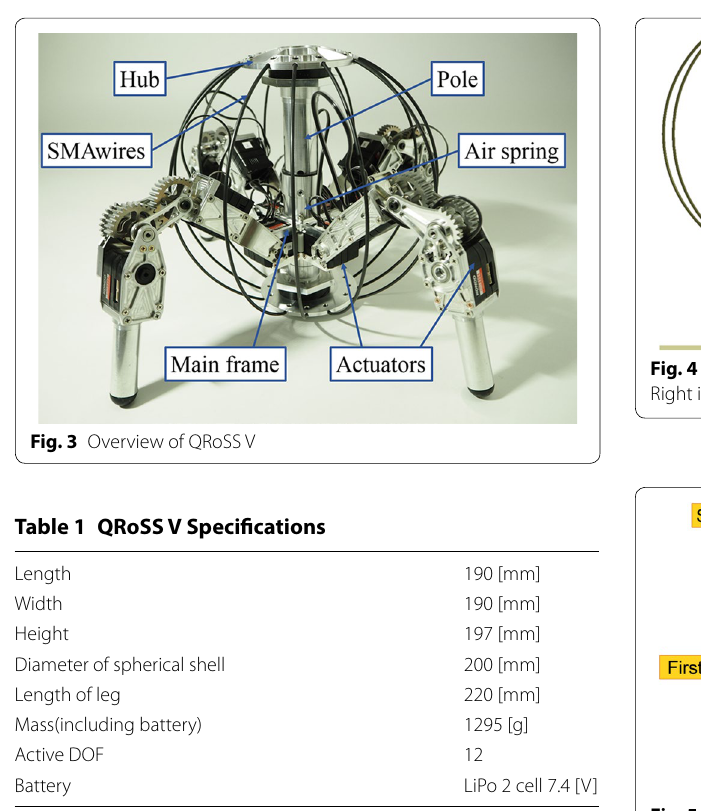
Fig. 5 Leg design of QRoSS